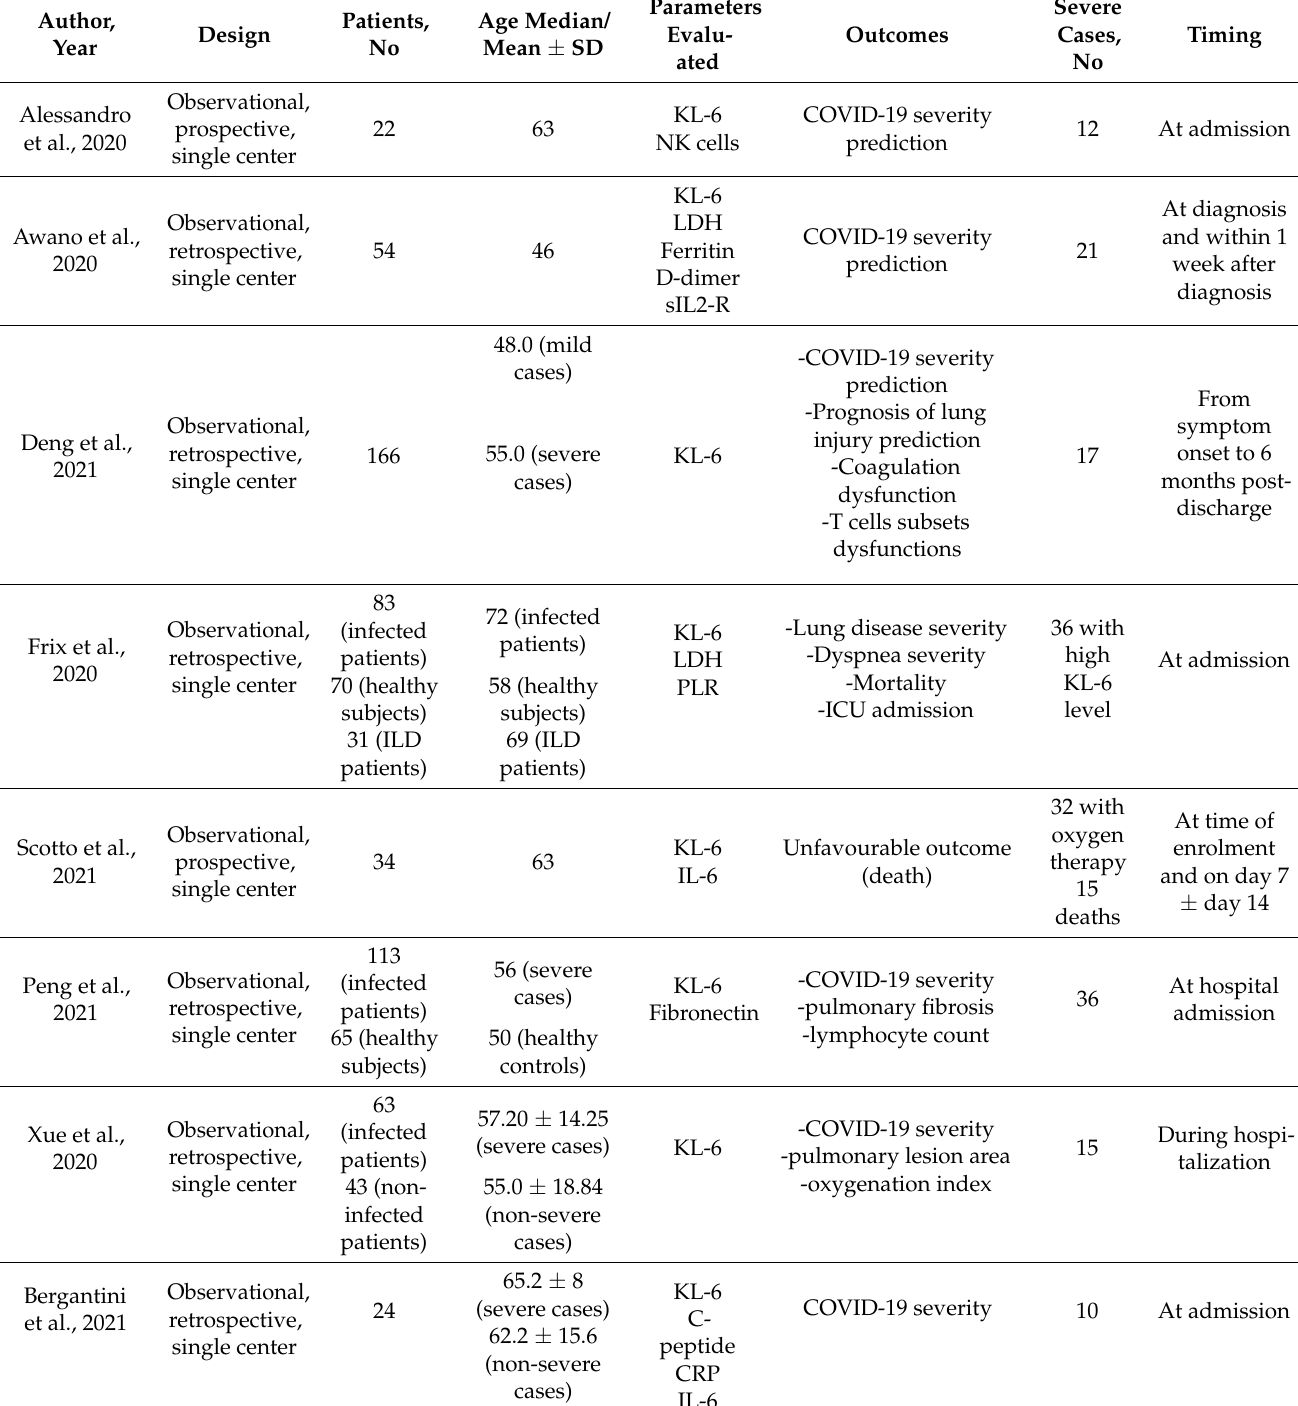
Table 1. General characteristics included in present systematic